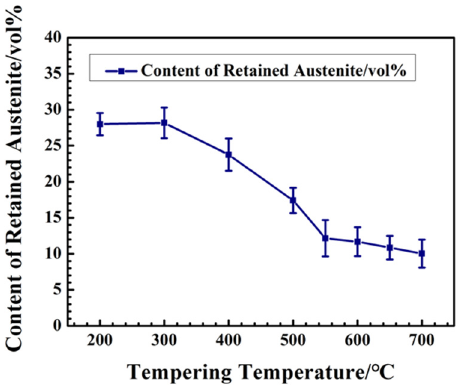
Figure 7. Content of Retained Austenite of M42 under different Tempering Temperatures.